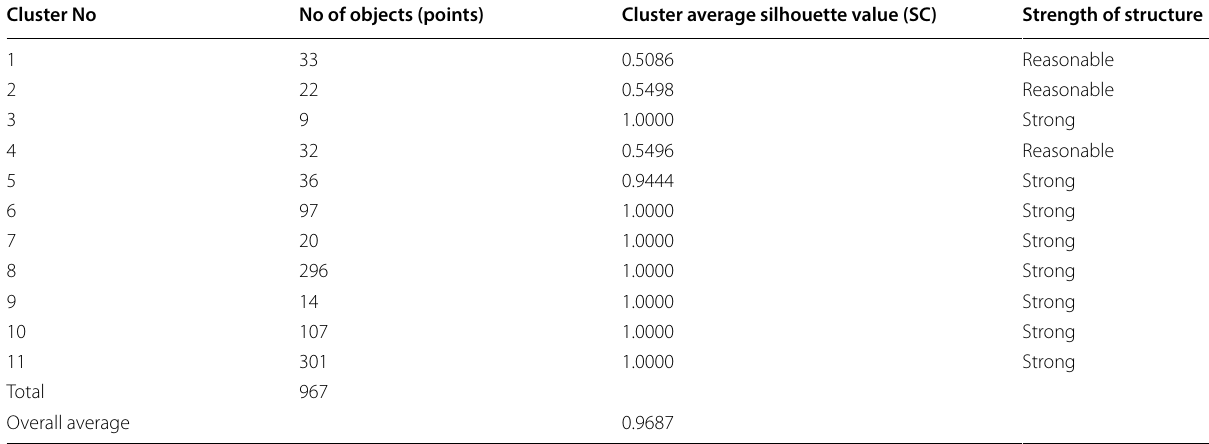
Table 6 Number of points clustered under each clusters with the strength of their structures